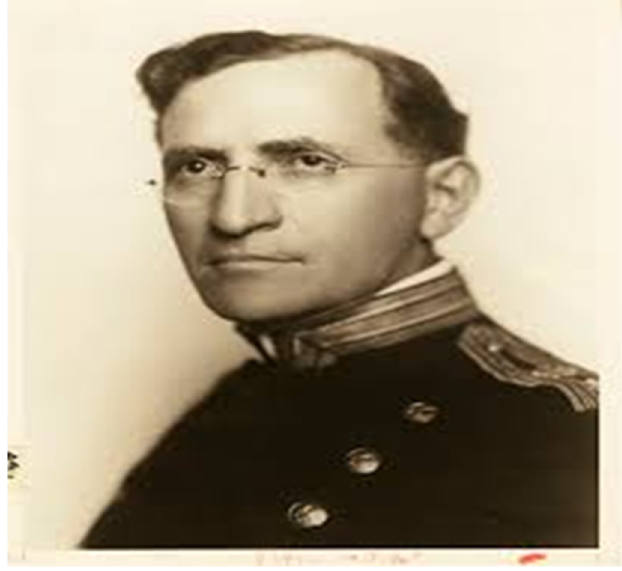
Figure 3. Dr. Joseph Goldberger ( 1874 – 1929 ) . Source: Orthomolecular Hall of Fame: https : //isom . ca/profile/joseph - goldberger/ (accessed on 31 March 2022).